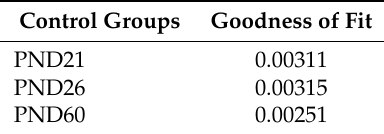
Table 6. Goodness of fit from Equation (5) for each dataset of the control group at PND21, -26 and